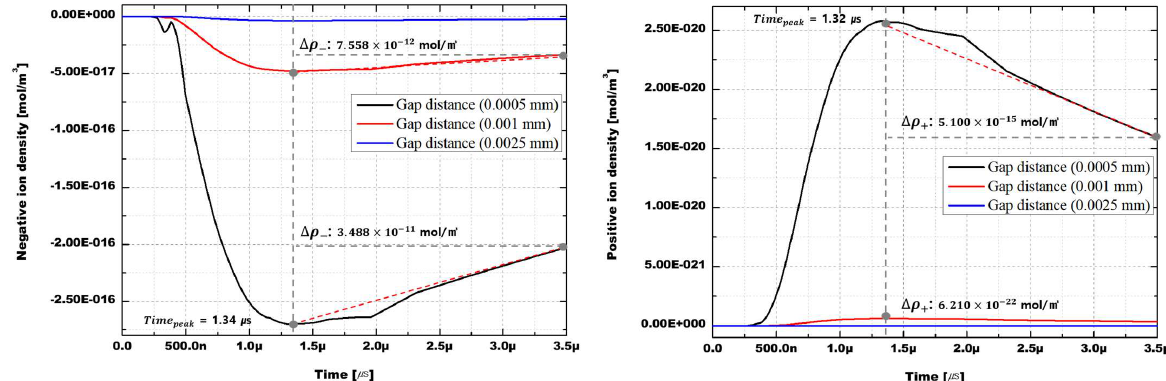
Figure 4. Negative and positive ion density as a function of time steps.